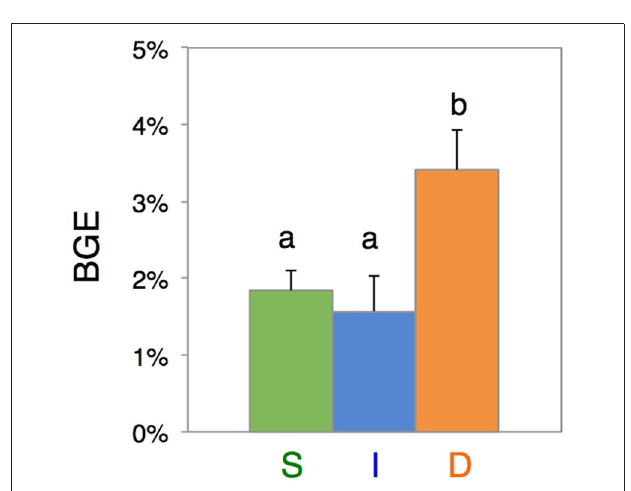
FIGURE 4 | Prokaryotic biomass incorporation. Bacterial growth efficiencies (BGE, %) estimated for each water layer: surface (S, green), intermediate (I, blue) and deep scattering layer (D, orange). BGE values were calculated for the same period of bacterial exponential growth phase and DOC decay in each experiment, ranging from 3.6 to 4.6 days. Different lower case letters represent statistically significant differences ( P < 0.05, post-hoc Fisher LSD test).